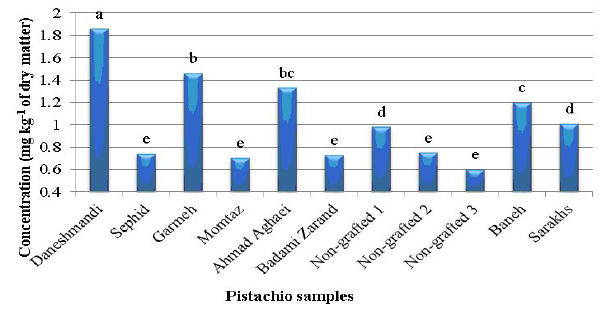
Fig. 3. The chromium concentration of eleven Iranian pistachio samples. (Each column with different letters is significantly dif- ferent (P < 0.05)